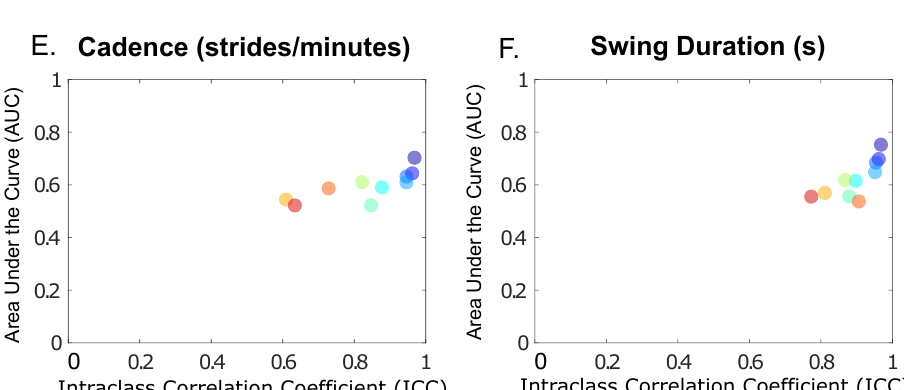
Figure 5. The intraclass correlation coe ffi cient (ICC) versus area under the curve (AUC) of ( A ) Gait speed, ( B ) Stride length, ( C ) Pitch at initial contact, ( D ) Double support, ( E ) Cadence, and ( F ) swing duration for various bout lengths. The total percentage of participants are shown inside the bracket of bout length